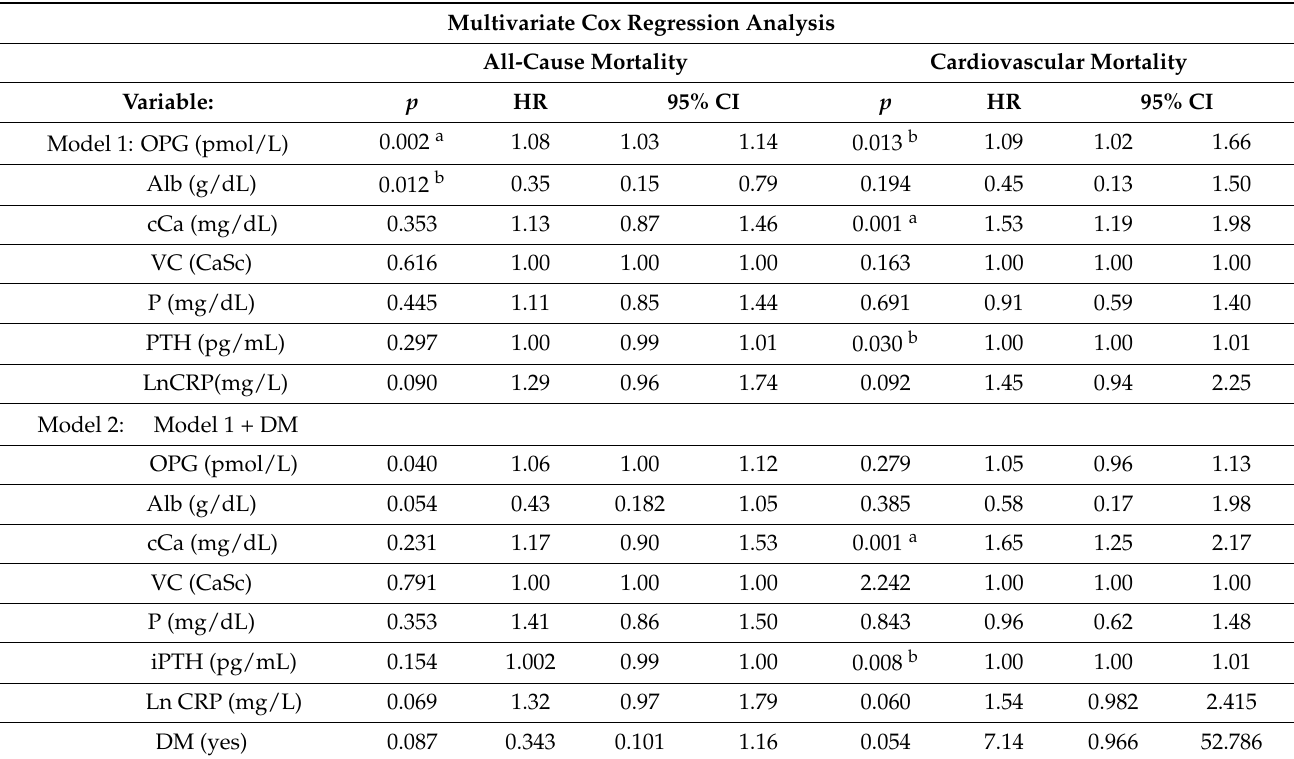
Table 5. Factors associated with all-cause and cardiovascular mortality in peritoneal dialysis patients. Multivariate Cox Regression Analysis All-Cause